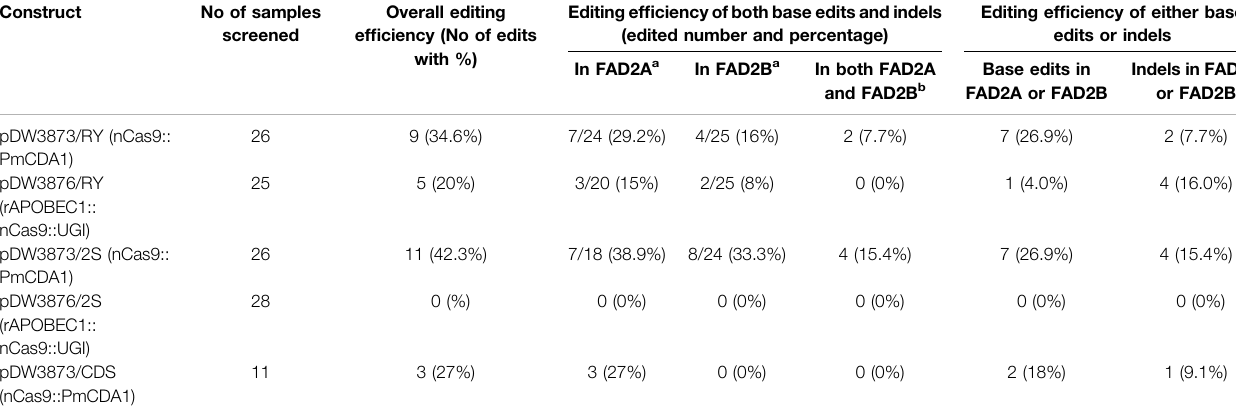
TABLE 2 | Evaluation of base editing ef fi ciency using two constructs in hairy root transformation assay.